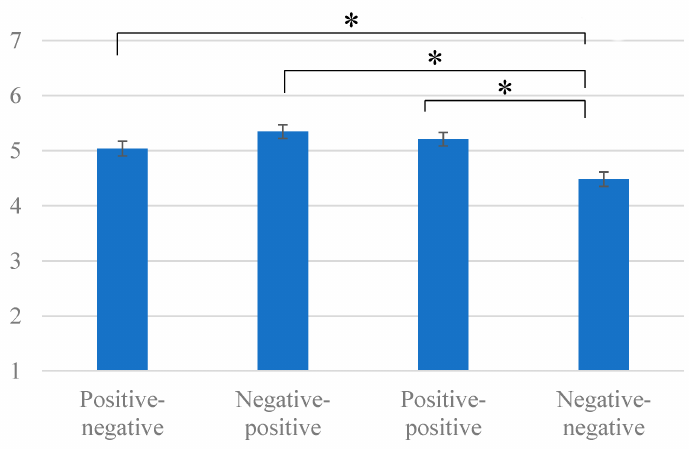
Figure 3. Average and S.E of media trust. * p <